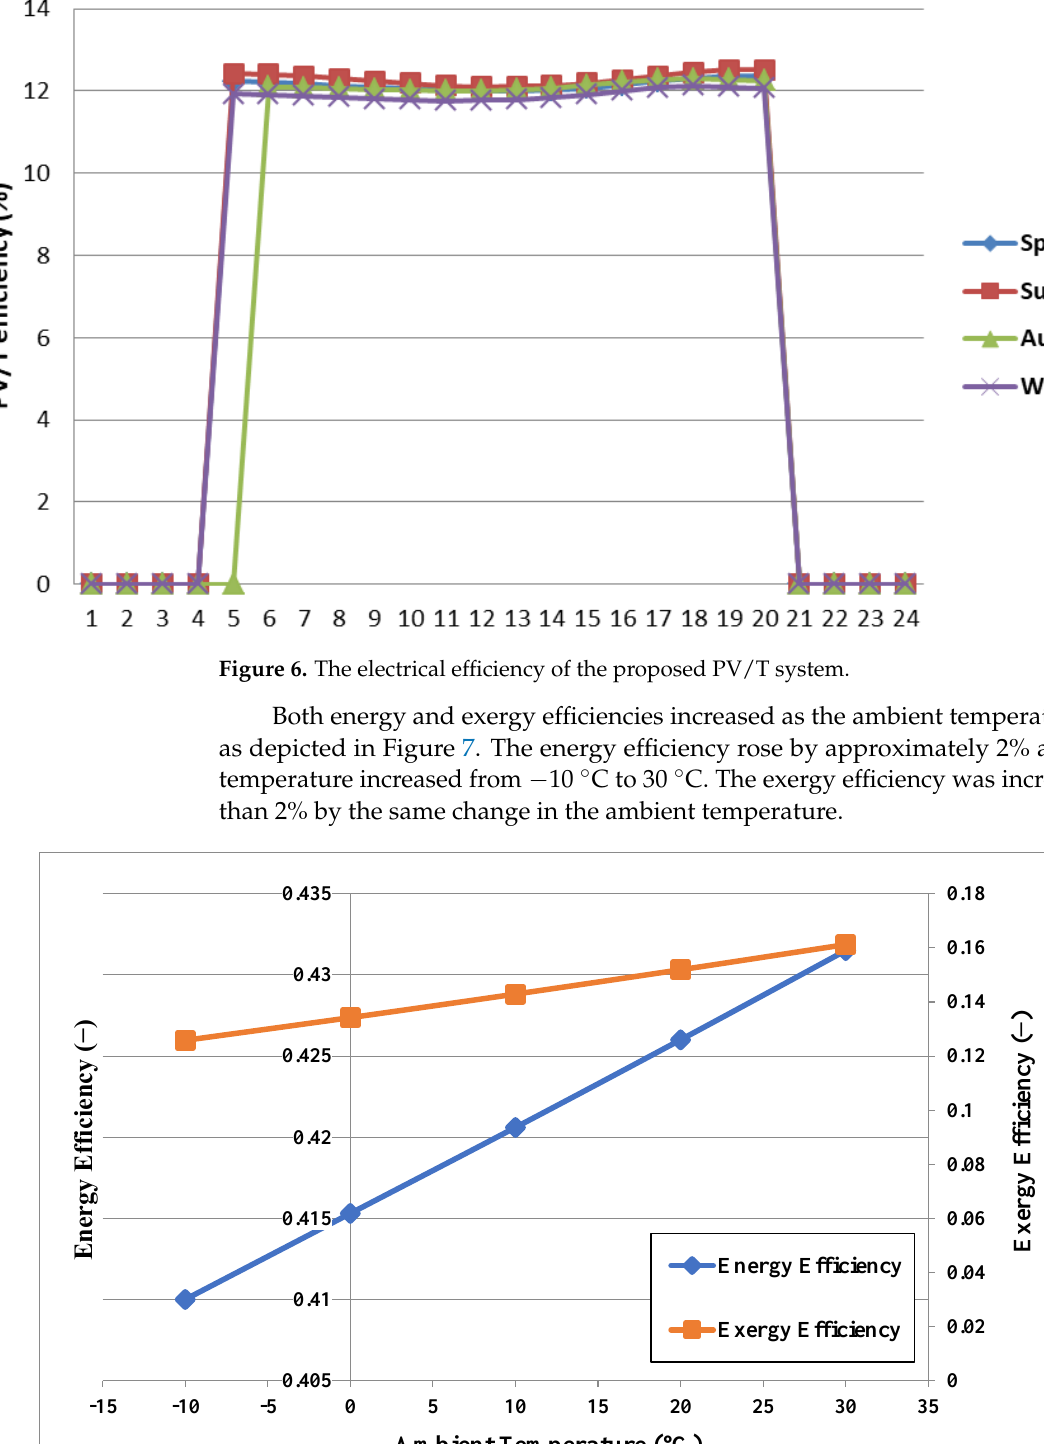
Ambient Temperature (°C) Figure 7. Energy and exergy efficiencies versus ambient temperature. Additionally, the exergy efficiency was enhanced as the warm water flow rate of the panels was increased. A rise in the warm water flow rate from 0.4 to 1 kg/s increased the exergy efficiency by 0.6%. The energy efficiency was reduced by more than 20% by the rise of the warm water flow rate. This is depicted in Figure 8.